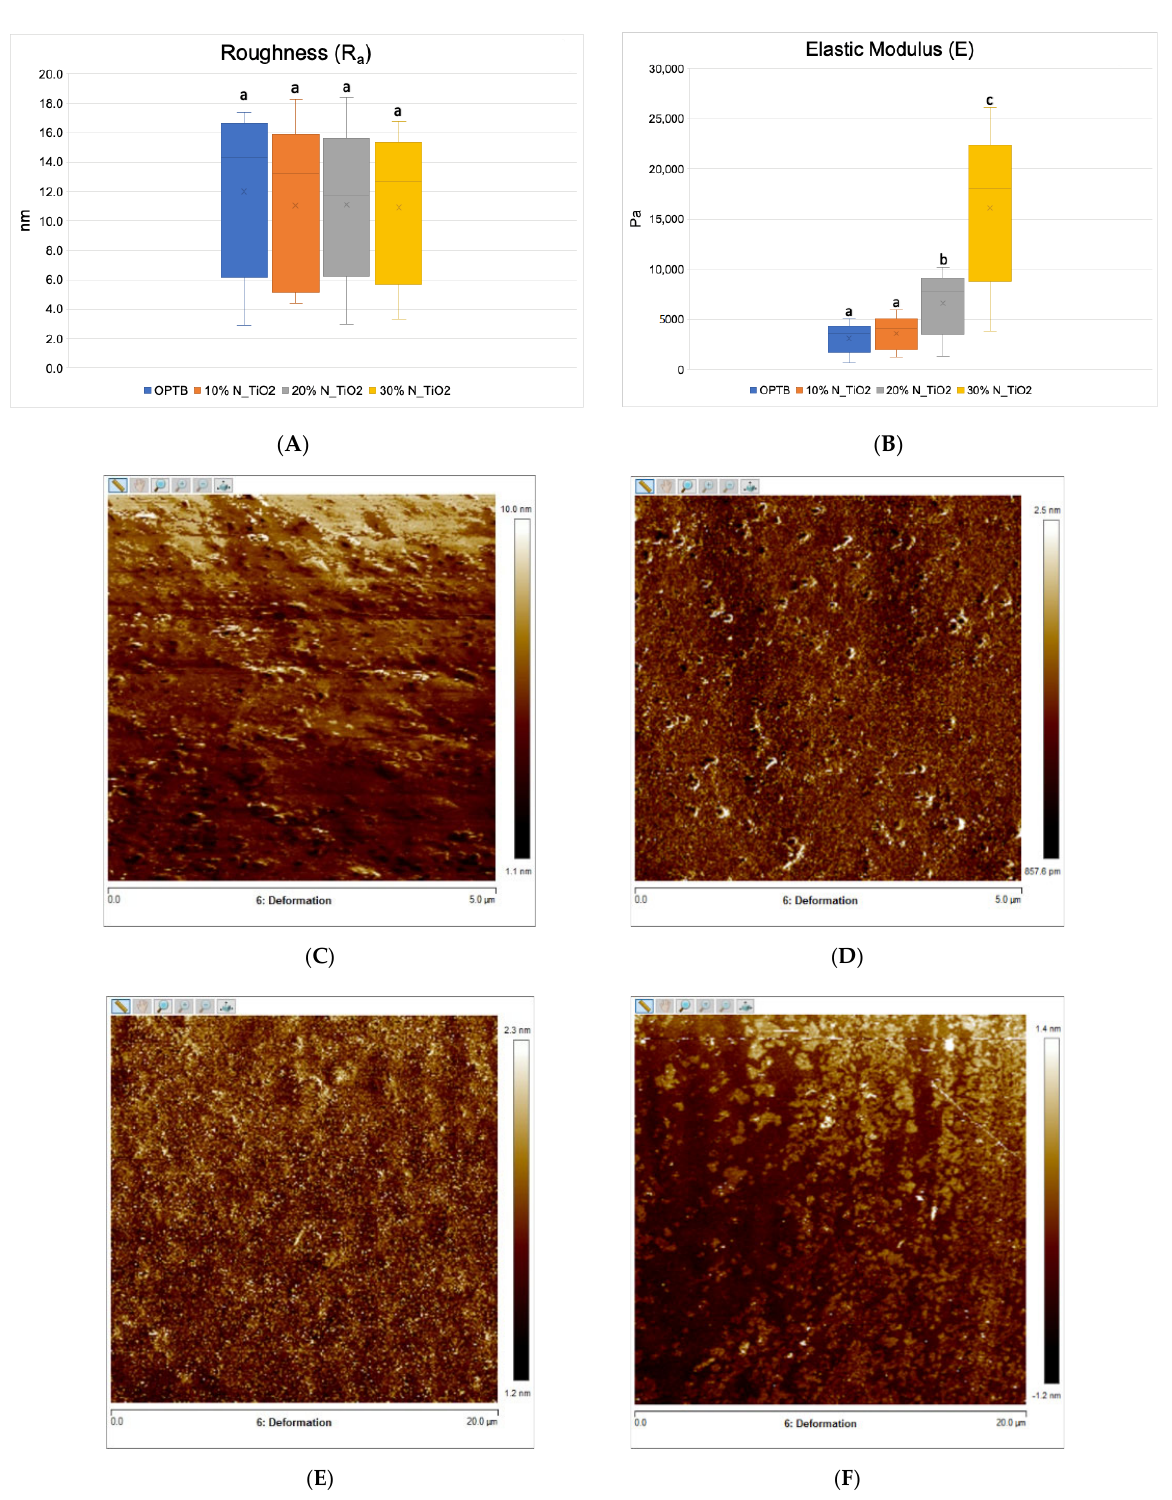
Figure 4. Mean and standard deviation values of ( A ) surface roughness and ( B ) elastic modulus of adhesives containing N_TiO 2 . ( C – F ) Raw two ‐ dimensional atomic force images, preceding filters, and post ‐ processing for data analysis, illustrating the mapping of samples deformation during QNM analysis for ( C ) OPTB, ( D ) OPTB+10% N_TiO 2 , ( E ) OPTB+20% N_TiO 2 , and ( F ) OPTB+30% N_TiO 2 . Side bars on individual images illustrate the range of deformation experienced by each material. Letters above bars in images ( A ) and ( B ) illustrate the SNK rankings and denote the presence of differences that are statistically significant ( p < 0.05).